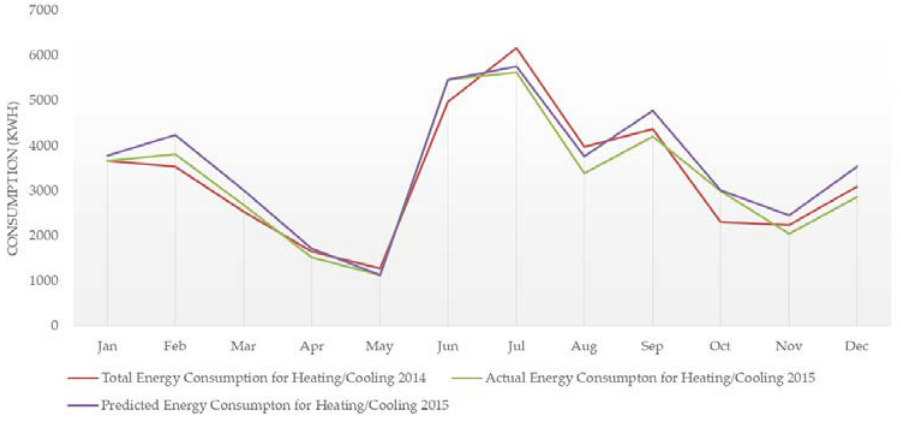
Figure 6. Energy consumption data (2014 and 2015)—1st year of operation.